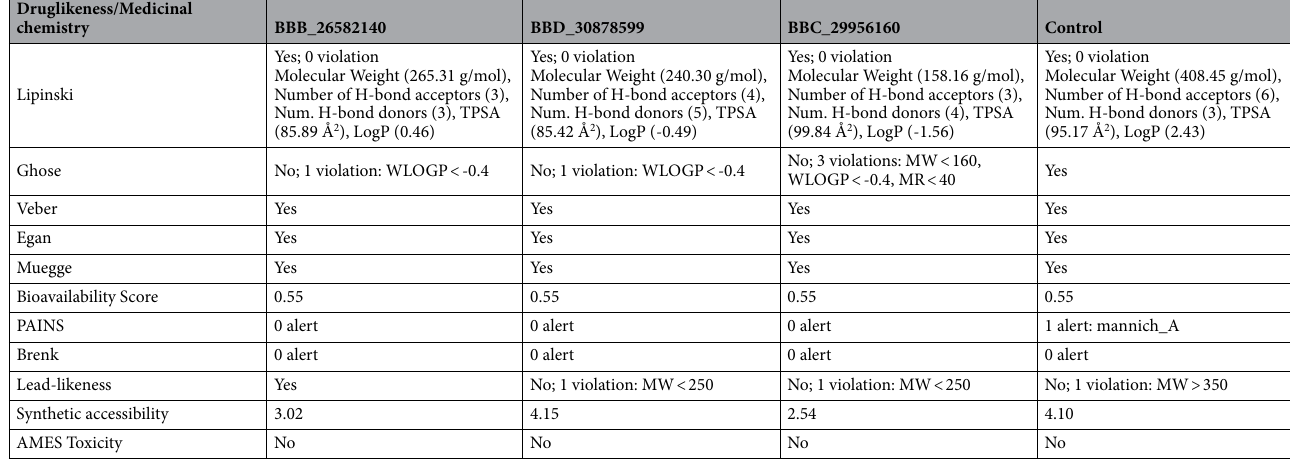
Table 4. Druglikeness/medicinal chemistry analysis of compounds and